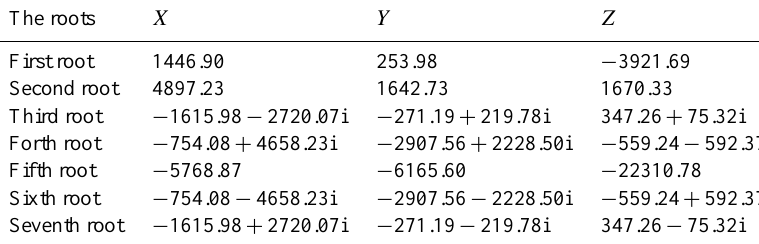
Table 1. The equilibrium roots of the summer SH equations in 2003. The roots